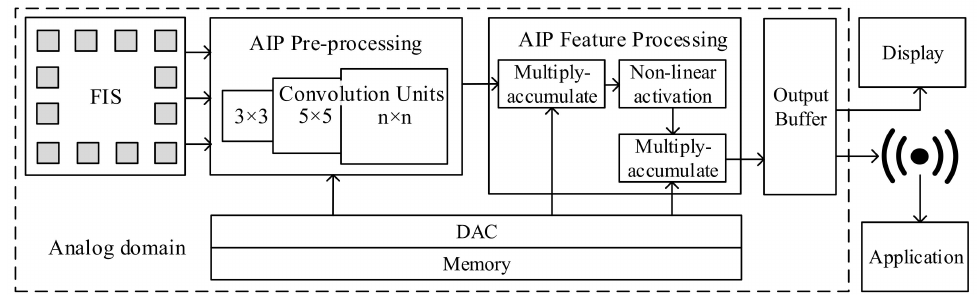
Figure 4. The model of analog-to-Information processing (AIP) architecture in fully flexible